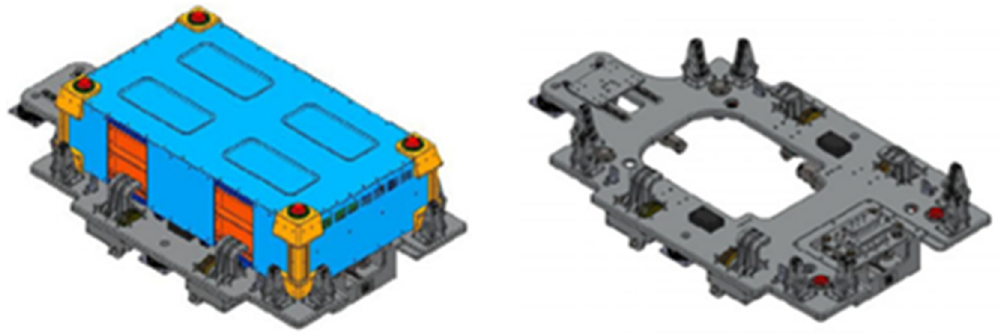
Figure 4. Battery mount shown with and without the